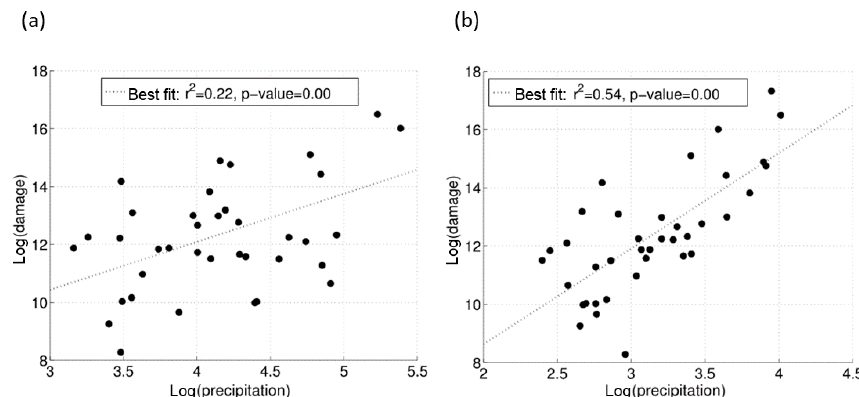
Figure 6. Scatter plot (a) damages ( D ) versus 24h precipitation and (b) damages ( D ) versus 30min precipitation in units of log(mm).